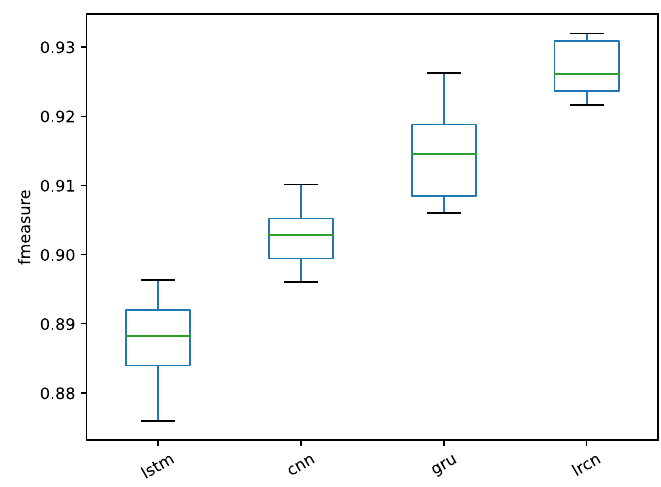
Figure 20. Comparison of the three baseline methods under the same conditions on the Jamendo dataset.